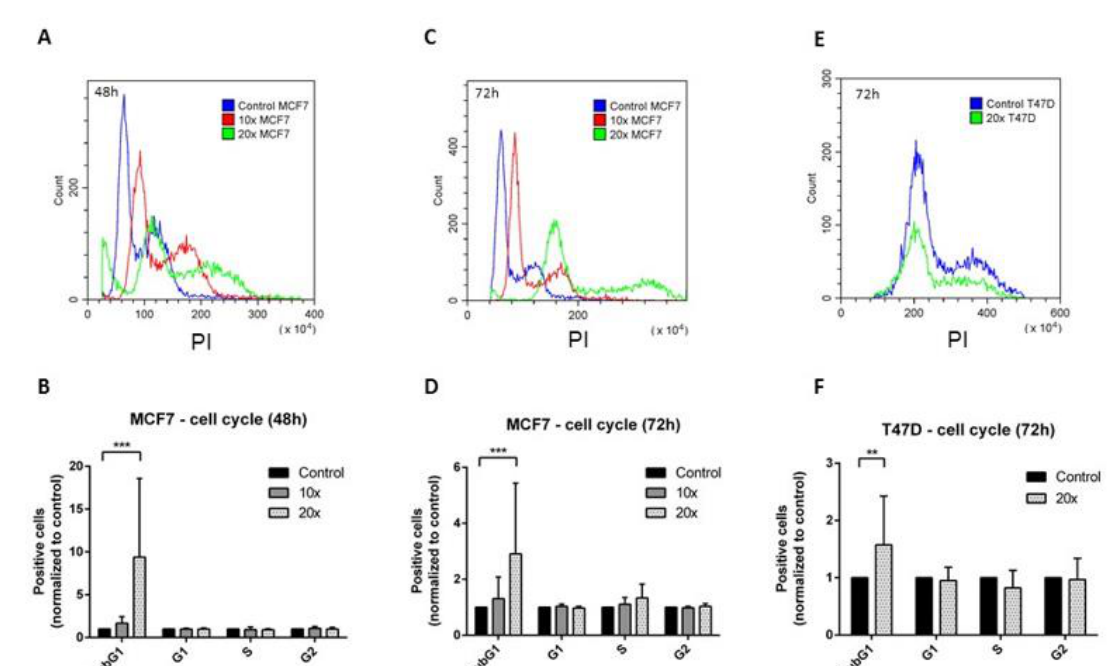
Figure 1. Cell cycle analysis of the MCF7 and T47D cells. SubG1 fractions of breast cancer cell lines were significantly increased after methyl-donor treatments compared to untreated controls. SubG1 fraction increased significantly in MCF7 cells both after 48 h ( A , B ) and 72 h ( C , D ), and in T47D cells after 72 h ( E , F ) treatments. Each bar represents the average number of positive cells normalized to control from at least 3 repeats ± SD. Statistical significance: **: p < 0.01 in T47D; ***: p < 0.001 in MCF7 cells. ×10 and ×20: concentrations of methyl-donors.